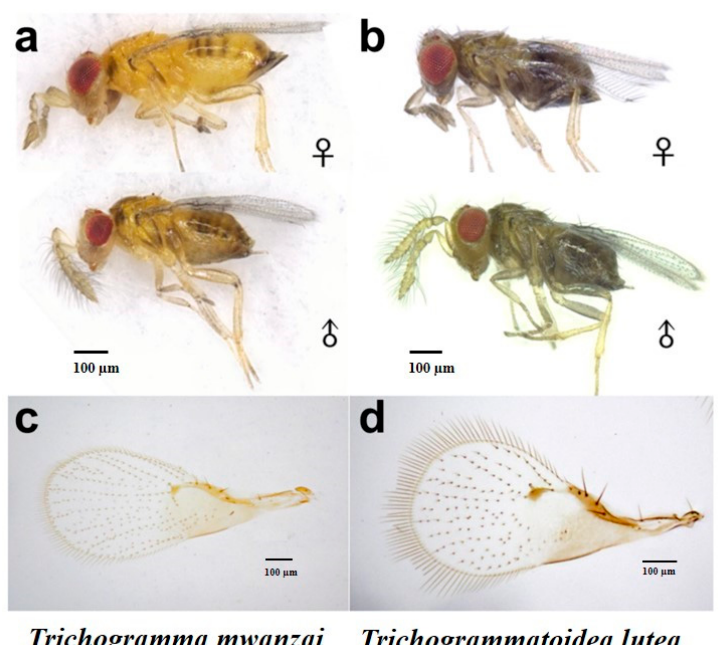
Figure 1. Comparison of adult morphological characters of two trichogrammatid species. (( a ): male and female of Trichogramma mwanzai ; ( b ): male and female of Trichogrammatoidea lutea ; ( c ): forewing of T. mwanzai ; ( d ): forewing of T. lutea ).